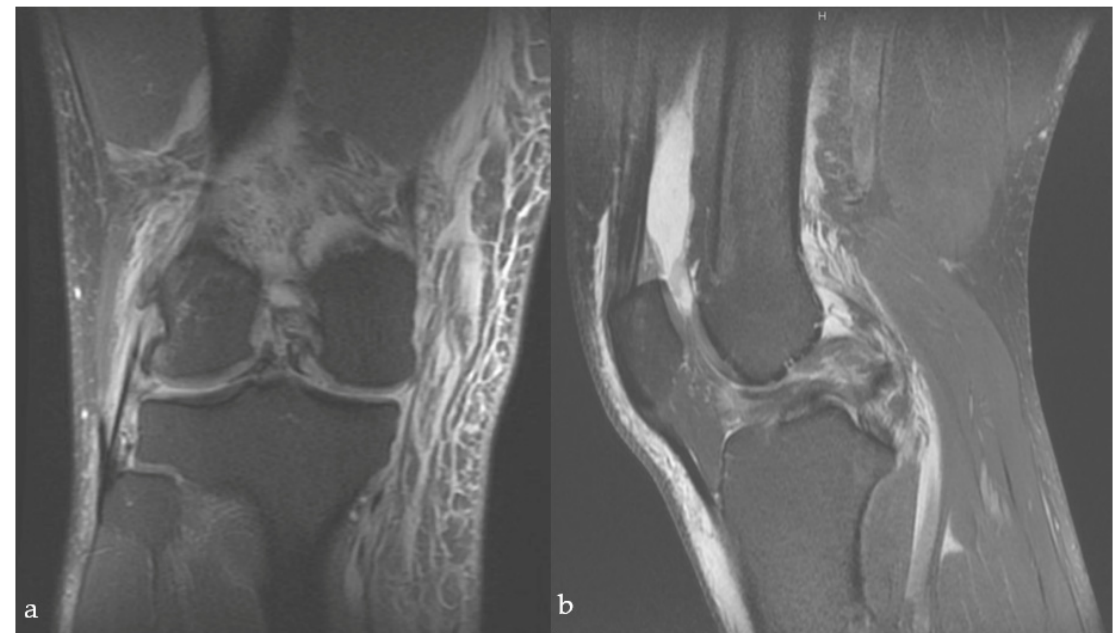
Figure 1. Sagittal ( a ) and frontal ( b ) view of a T2-weighted MRI scan of a right knee 2 days after KD type IV with disruption of both cruciate and bilateral bucket handle tear.